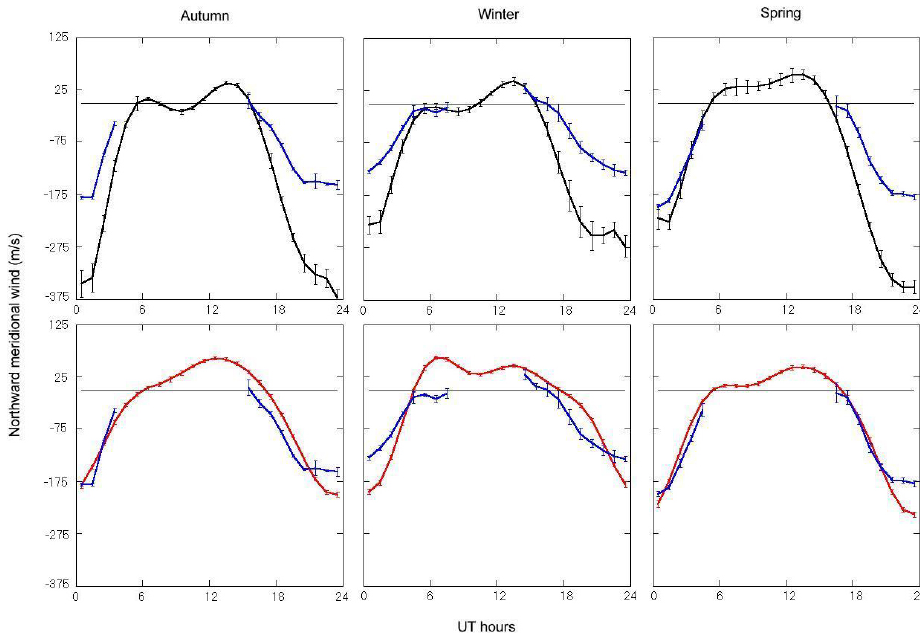
Fig. 11. As for Fig. 10 but in this case for high solar